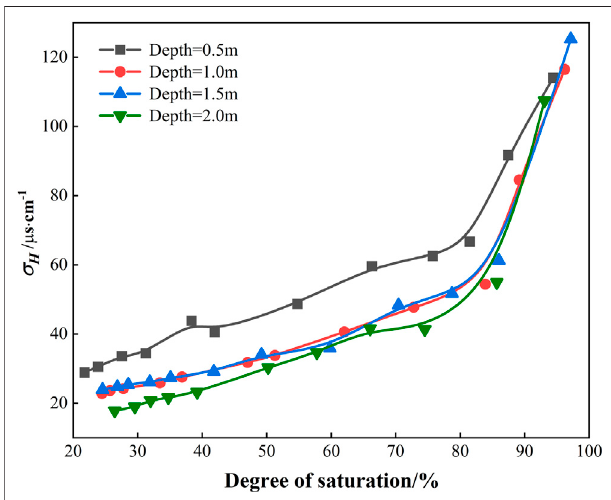
FIGURE 6 | Relationship between horizontal electric conductivity and degree of